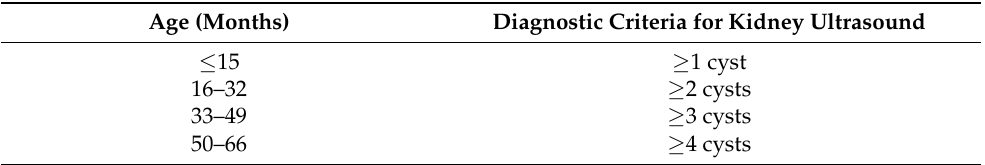
Table 1. Diagnosis criteria of feline PKD according to the age of the cat. Age (Months) Diagnostic Criteria for Kidney Ultrasound ≤ 15 ≥ 1 cyst 16–32 ≥ 2 cysts 33–49 ≥ 3 cysts 50–66 ≥ 4 cysts Data extracted from Guerra et al. (2018)